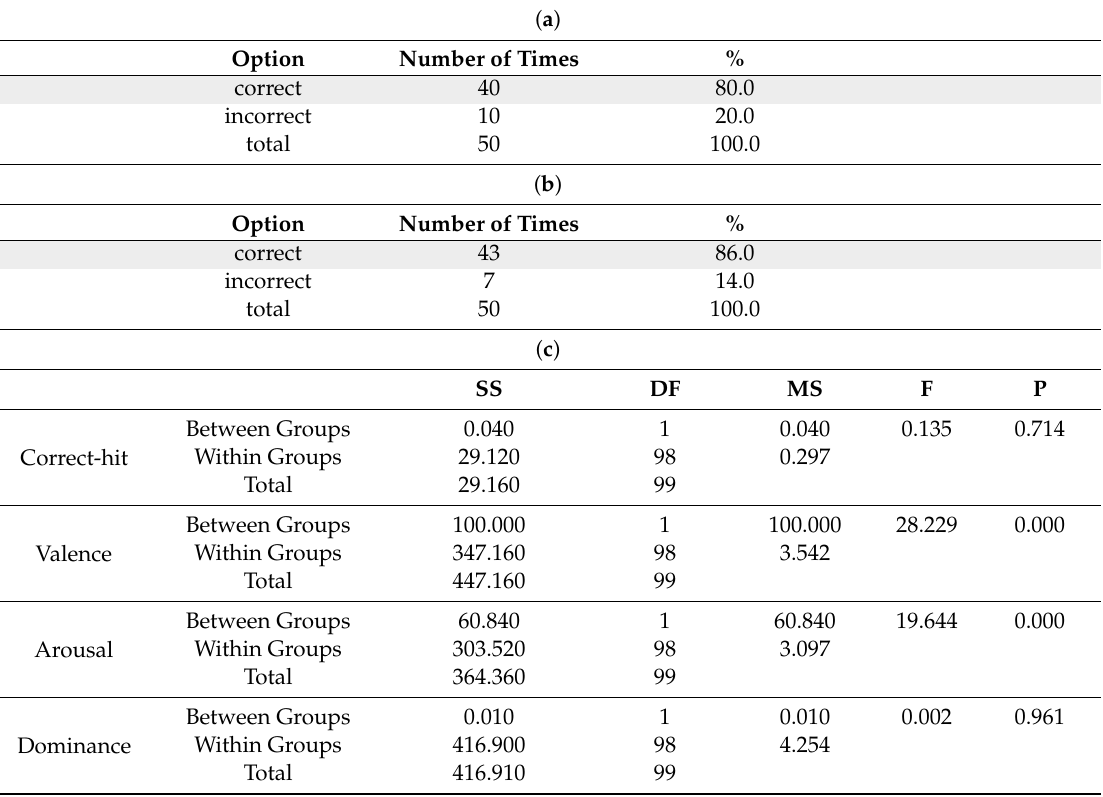
of the cleaning task with the virtual prototype. ( c ) ANOVA for usability assessment